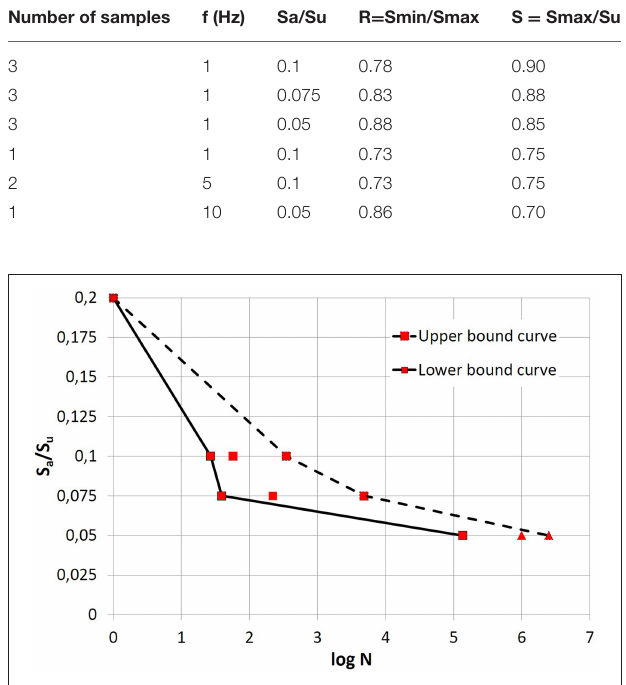
FIGURE 1 | Ronca et al. (2004) fatigue curves: experimental data obtained.